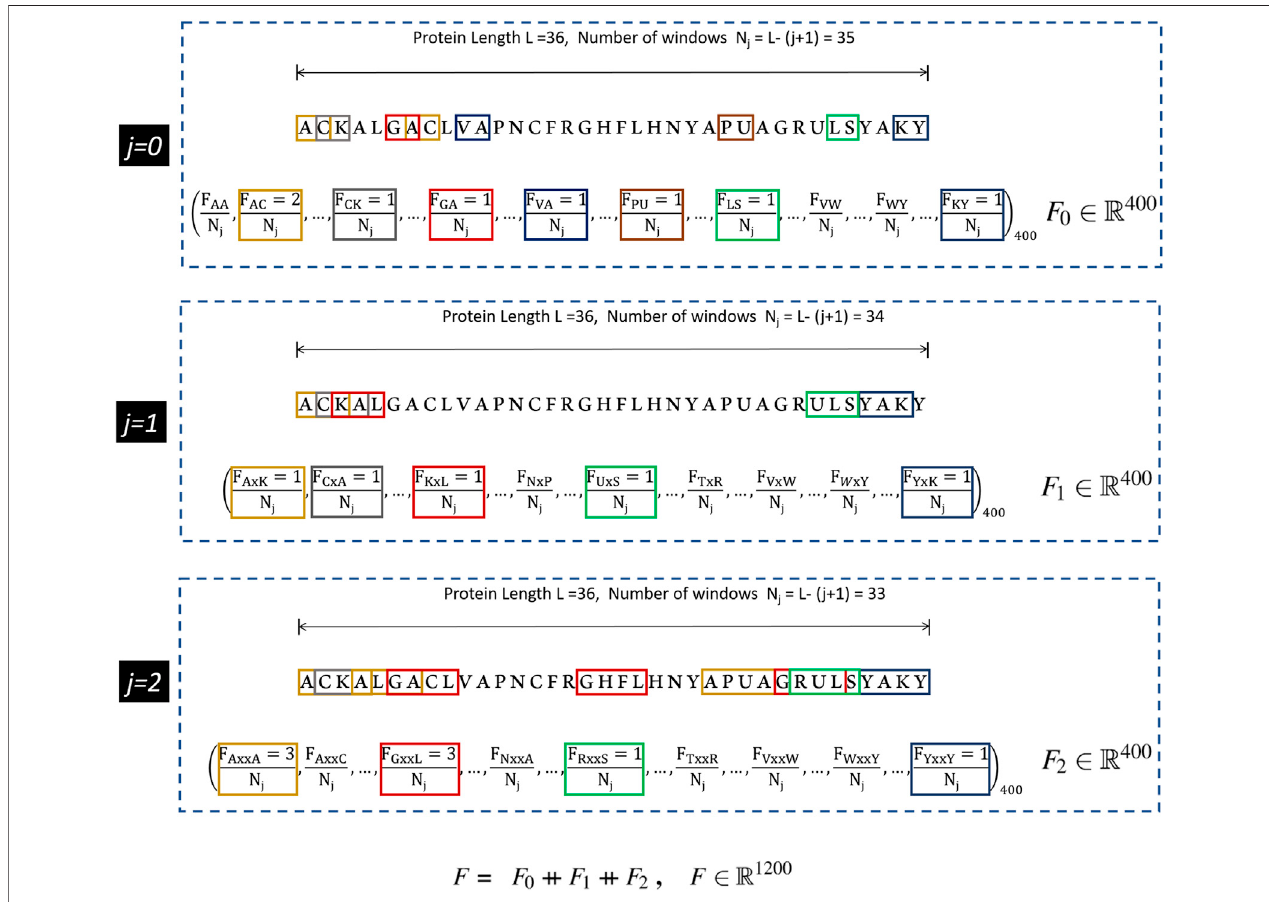
FIGURE 1 | CKSAAP feature extraction mechanism for k (cid:1) 2. Extracted from Usman et al. (2020).